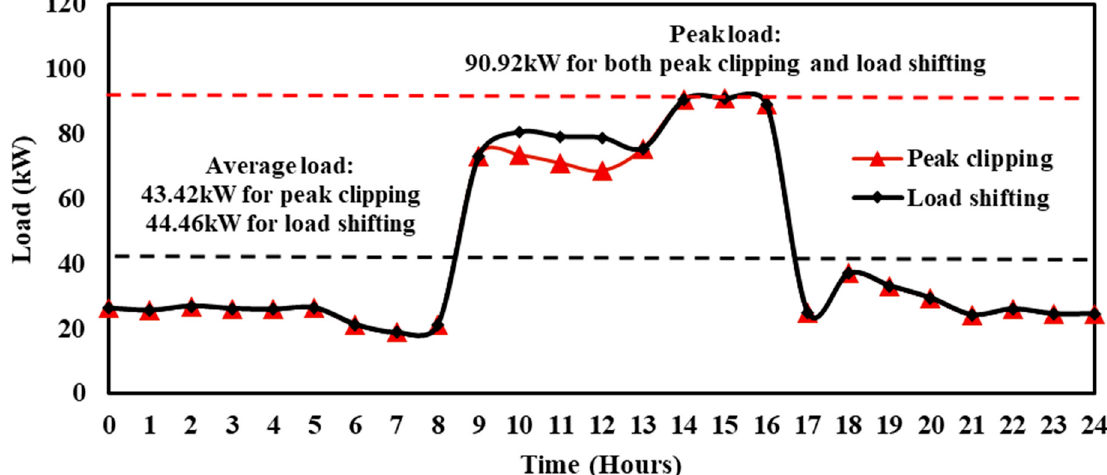
Figure 10. Comparison of DSM approaches in daily load profile curve.